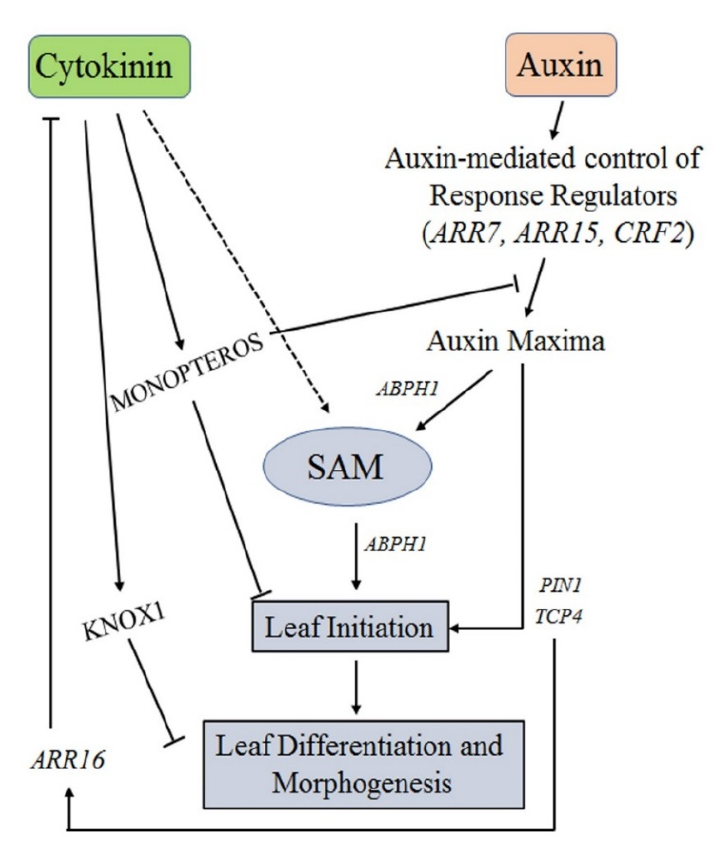
Figure 2. A model detailing the auxin and cytokinin interplay during leaf development and mor- phogenesis. Solid lines represent the established regulatory connections, whereas the dashed line indicates the possible connection. Line ending with a crossed line indicates the negative regulations.